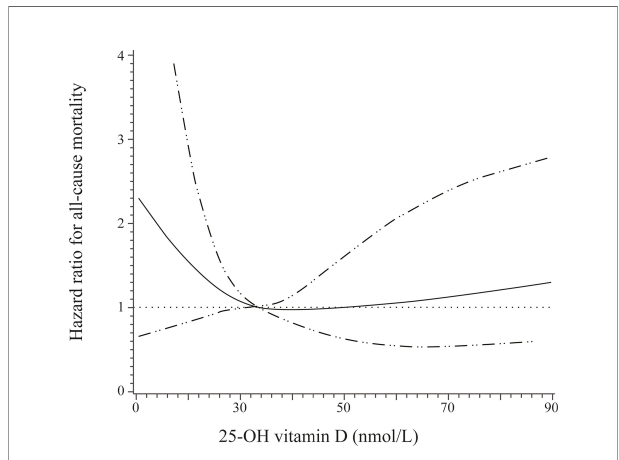
FIGURE 3 | Adjusted hazard ratios (solid line) and 95% con fi dence interval (dashed lines) for all-cause mortality according to different levels of 25-OH vitamin D. Adjusted for age, sex, insurance status, smoking, and alcohol